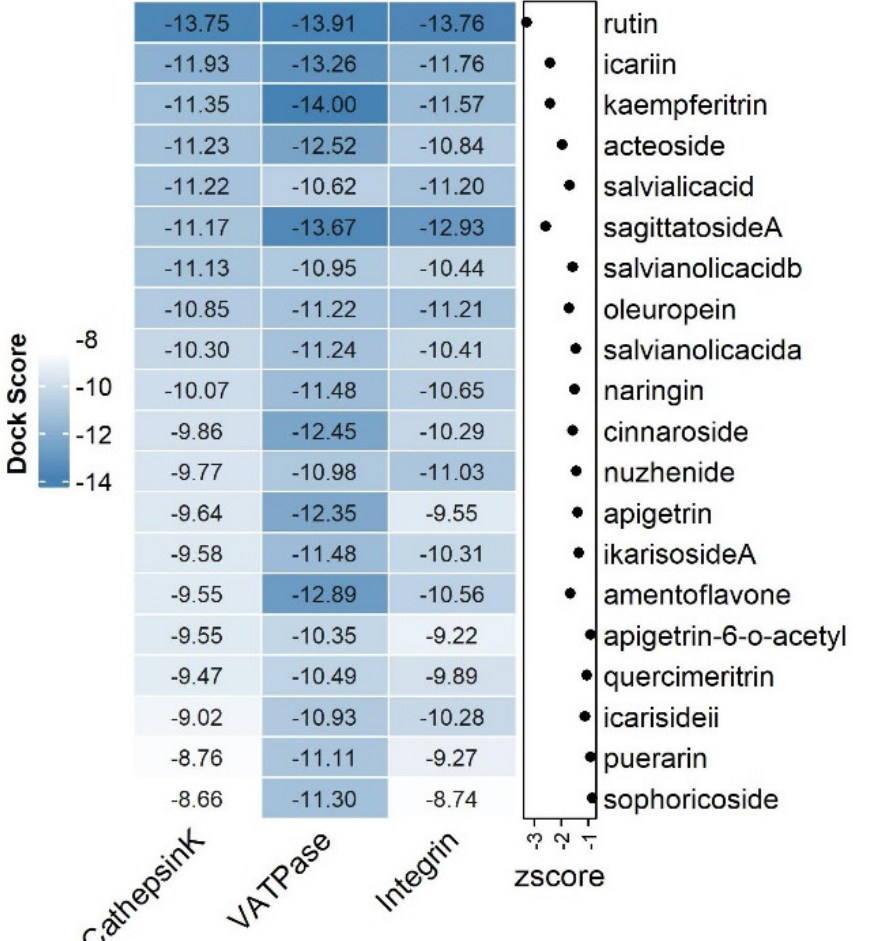
Figure 3. The binding energies of phytochemicals. A heatmap represents top 20 molecular docking score of herbal compounds against Cathepsin K, V-ATPae, and α v β 3 integrin receptor. Color values correspond to binding energy assessed with AutoDock scoring function. The normalized value (z-score) of each docked compound represents an individual dot plot in the scatter plot.